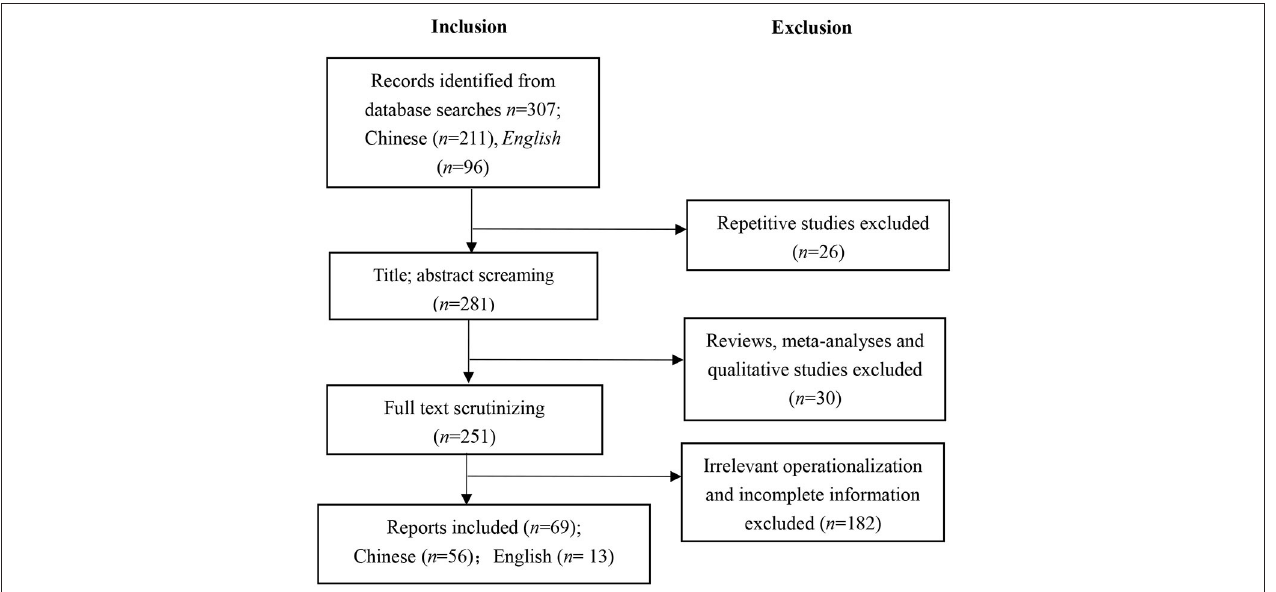
FIGURE 1 | Literature search and inclusion